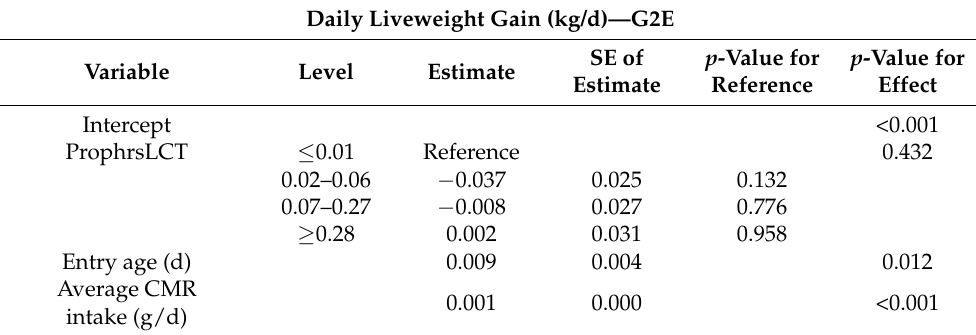
Table 6. Final mixed model describing variables affecting daily liveweight gain (DLWG) from entering the group housing igloo pen until the end of the study period